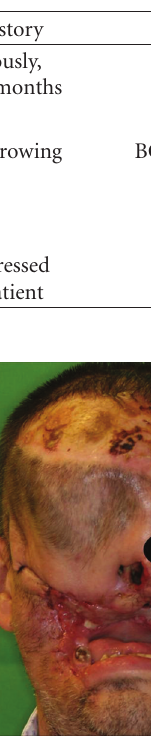
Figure 3: Case 1: The patient is tumor-free, but his face has not been reconstructed functionally or esthetically.